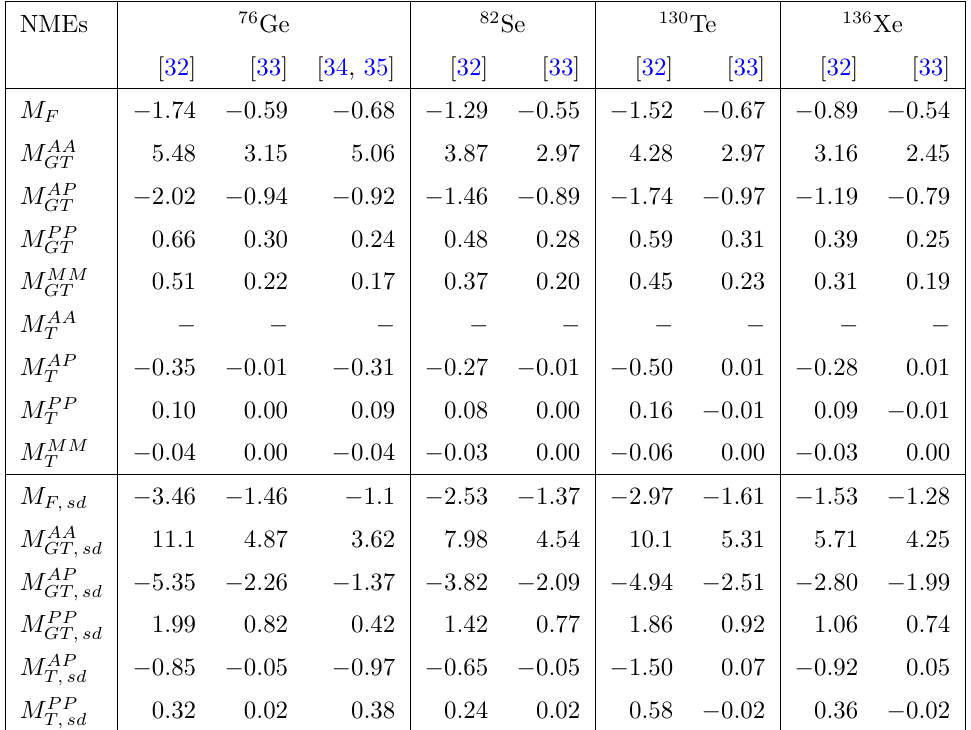
Table 2 . Comparison of NMEs computed in the quasi particle random phase approximation [32], shell model [33], and interacting boson model [34, 35] for several nuclei of experimental interest. All NMEs are expected to be (1) in the chiral EFT power counting, except for M MM O which are formally suppressed by (cid:15) 2 . This suppression is partially compensated by large isovector (cid:31) nucleon magnetic moment g M 4 : 7. The power counting expectations agree fairly well with the ’ actual numerical values for the Fermi (F) and Gamow-Teller (GT) NMEs, while the tensor (T) NMEs are usually smaller. The NMEs are de(cid:12)ned in eq. (A.10) of appendix